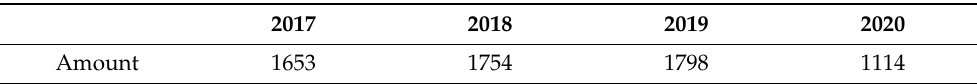
Table 7. The number of courses in the same